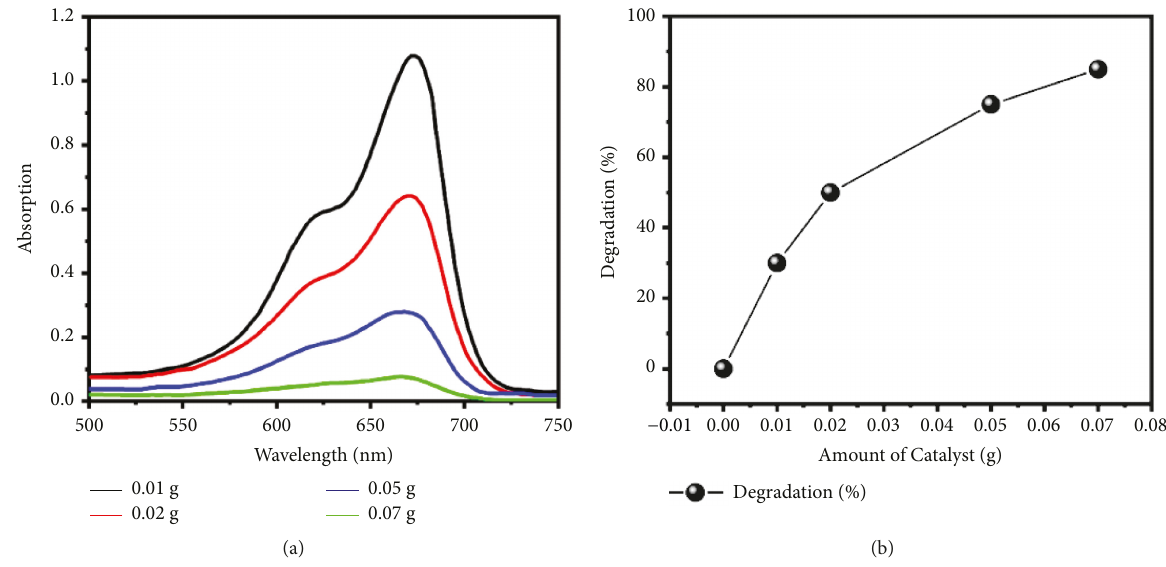
Figure 11: (a) Absorption spectra of MB dye by various concentrations of Cu-doped ZnO and (b) % degradation of methylene blue at various catalyst amounts.